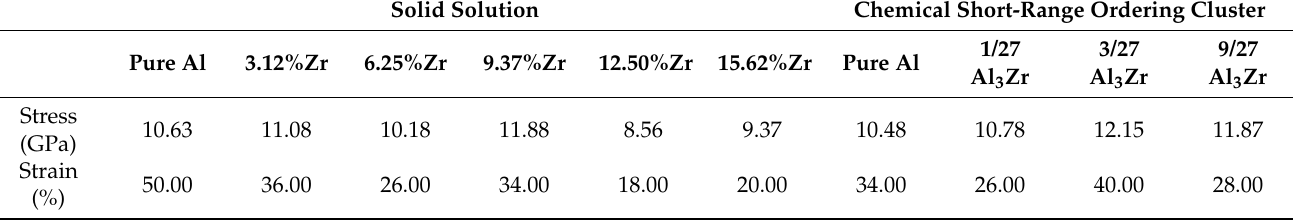
Table 4. The calculated ideal tensile strength in the [001] direction for the models of the Al solid solution with varied compositions of the solute atom Zr and Al supercell models with the chemical short-range ordering clusters L1 2 -Al 3